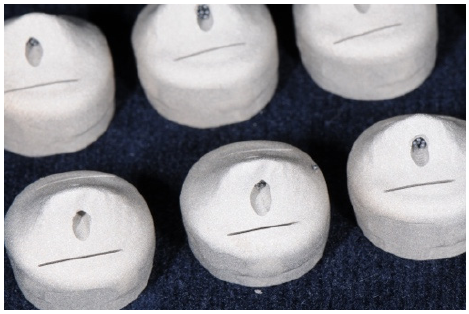
Figure 3. Cobalt ‐ chromium secondary crowns with a hole for the pull ‐ off test directly after sintering. Figure 3. Cobalt-chromium secondary crowns with a hole for the pull-off test directly after